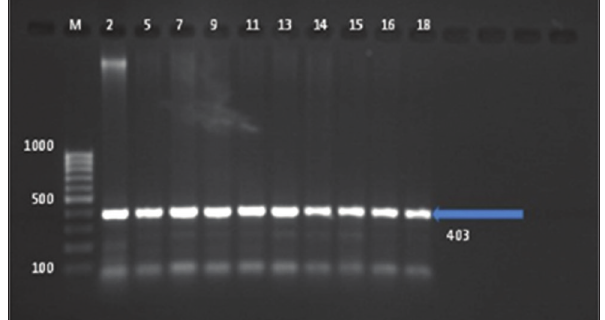
Figure-2: Amplification of bla SHV, bla TEM, and bla CTX-M genes by a multiplex polymerase chain reaction from Salmonella isolates. Ethidium bromide-stained agarose gel (75 V at 1 h). Lane M, DNA molecular size marker (100 bp ladder); lanes 2, 5, 7, 9, 11, 13, 14, 15, 16, and 18 positive with bla TEM gene (403 bp).